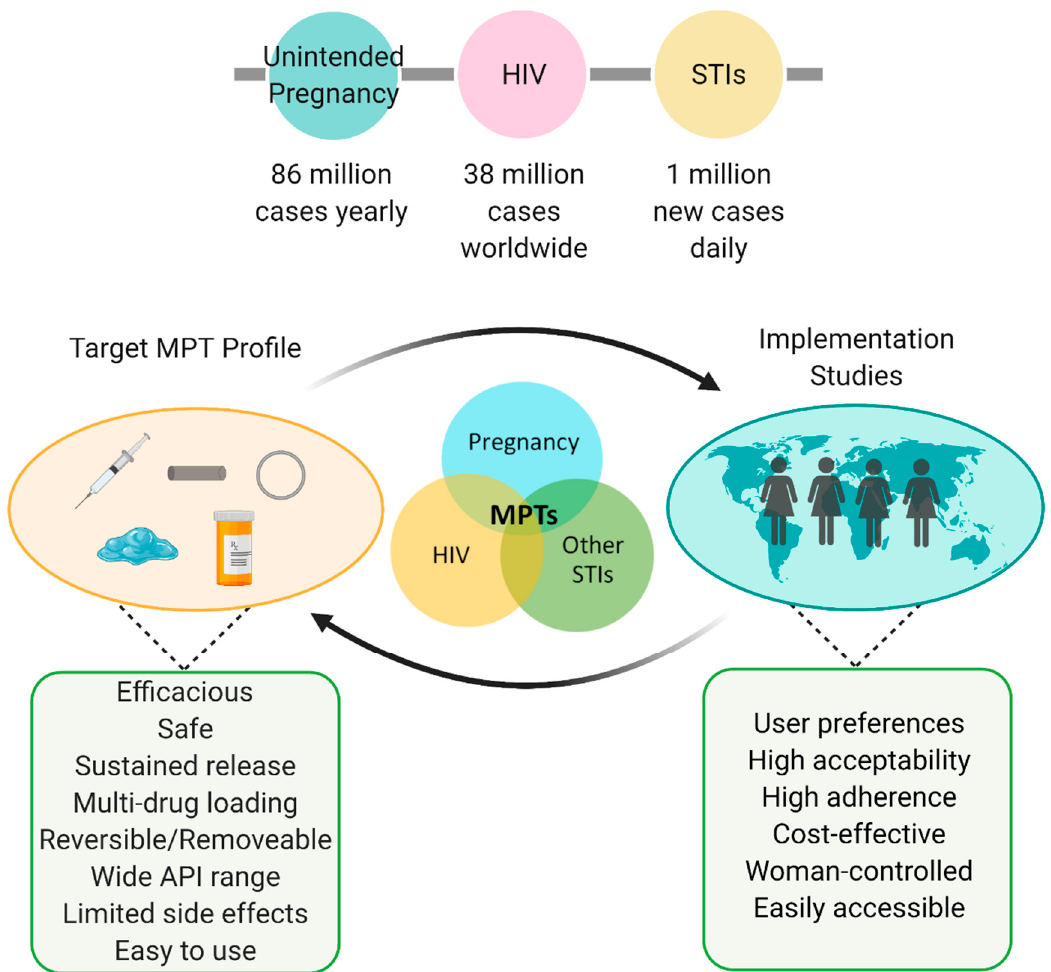
Figure 4. MPT considerations and summary. Globally high prevalence of HIV, STIs, and unplanned pregnancies indicate the urgent need for improved preventative care. Successful MPTs consist of a feedback loop between formulation development (e.g., injectables, implants, intravaginal rings, gels/films, oral tablets) and implementation studies. Figure created with BioRender.com, accessed on 19 July 2021.